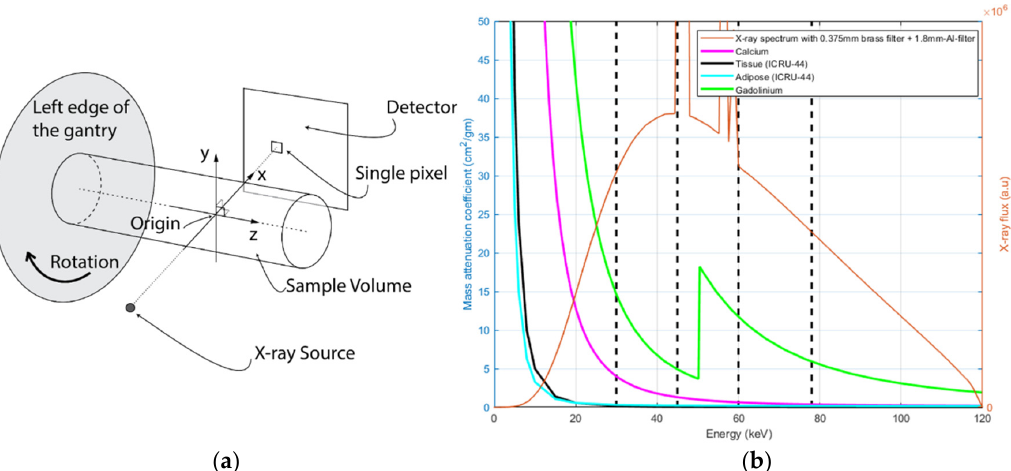
Figure 1. ( a ) Schematic of the MARS small animal spectral scanner; ( b ) the mass attenuation coefficients for calcium, tissue, adipose and gadolinium are shown (left axis) and simulated X-ray spectrum at 120 kVp with 0.375 mm external brass filter together with a 1.8-mm-Al (equivalent) intrinsic filtration (right axis). Vertical dotted lines show user specific energy thresholds.